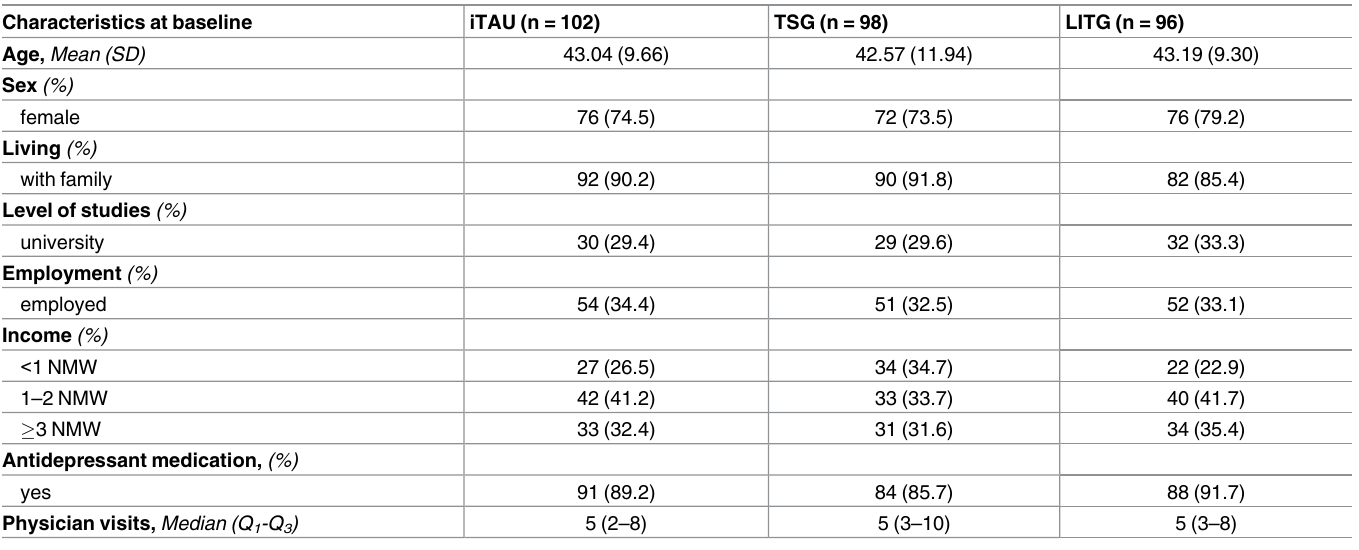
Table 2. Baseline sociodemographic characteristics of the patients by treatment